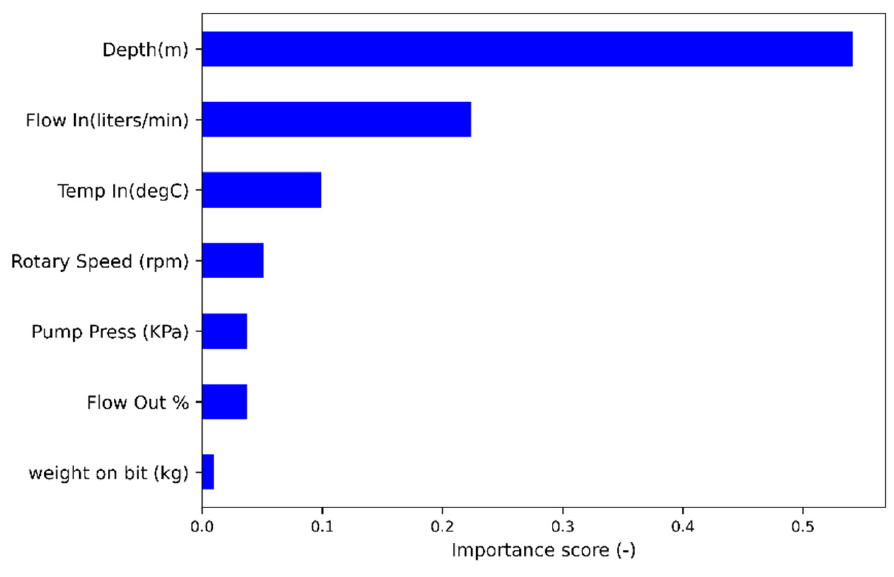
Figure 12. Feature importance.